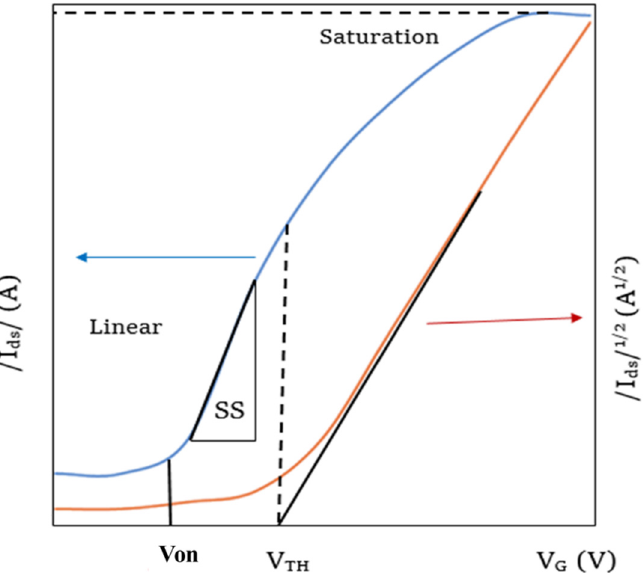
Figure 6. Transfer characteristics curve of a perovskite thin film FET with linear and saturated regimes.